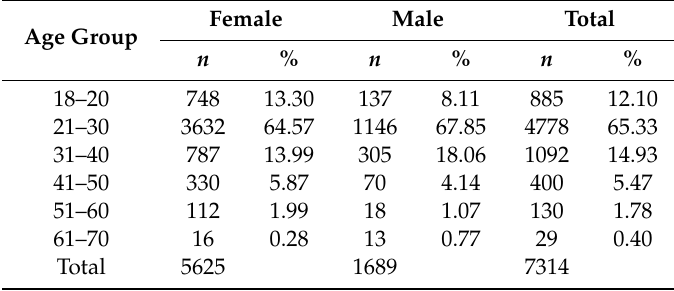
Table 1. Distribution of enrolled subjects by gender.